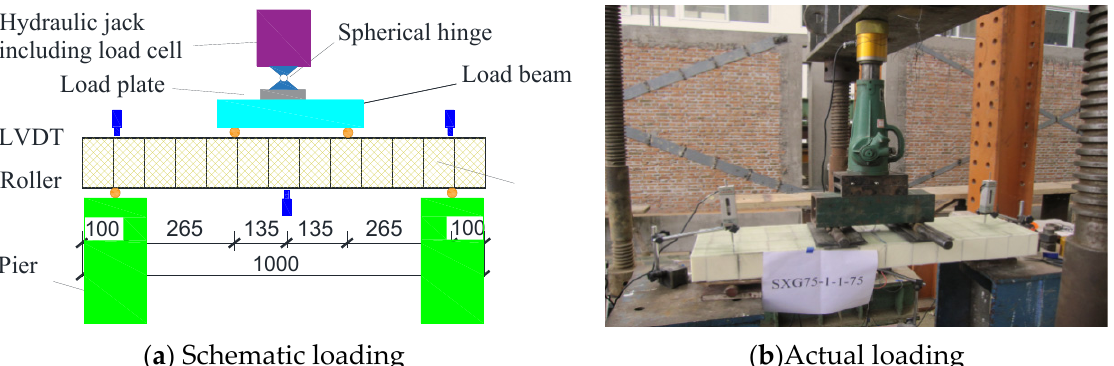
Figure 8. Loading schematic for single-way simply supported SLCPs. Table 4. Details of specimens.